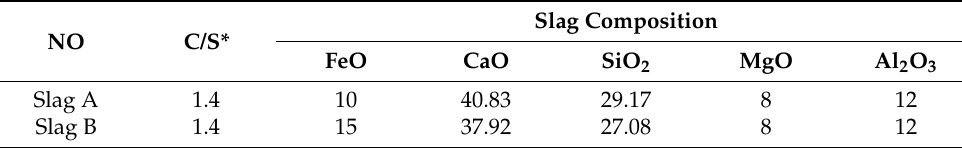
Table 1. Chemical composition of slags,